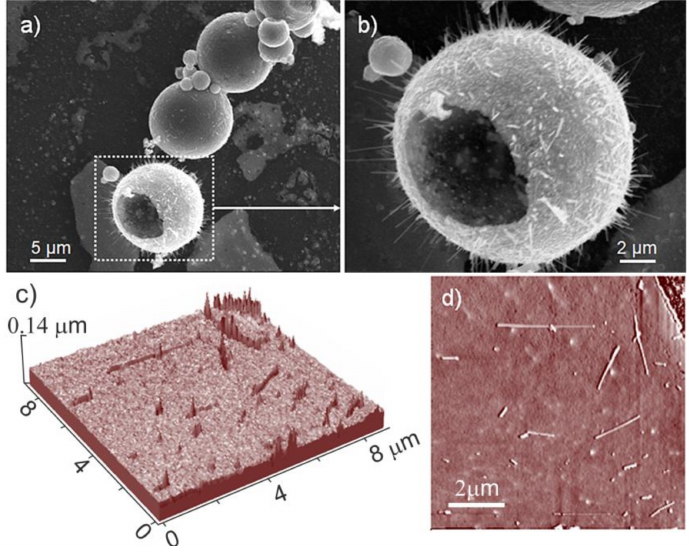
Figure 6. ( a ) SEM image of ZnO spherical cages grown on Au thick film (50 nm thick) at 700 ◦ C for 3 h; ( b ) enlarged view of ( a ); large-scale non-contact AFM (9 × 9 µ m) topography of a region of a ZnO spherical cage; ( c ) three-dimensional; and, d ) top view images.